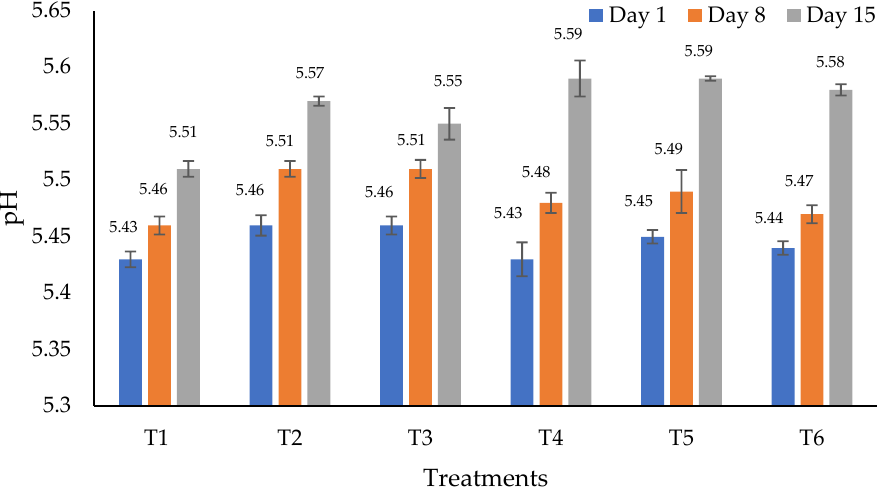
Figure 1. pH values (mean) of beef hamburgers added to essential oils of rosemary ( Rosmarinus officinalis ) and garlic ( Allium sativum ) and oleoresins of chipotle pepper ( Capsicum annum ). T1 = control, T2 = 1% garlic essential oil ( w / w ), T3 = 1% rosemary essential oil ( w / w ), T4 = 0.5% chipotle pepper oleoresin ( w / w ), T5 = 1% garlic essential oil + 0.5% chipotle pepper oleoresin ( w / w ) and T6 = 1% rosemary essential oil + 0.5% chipotle pepper oleoresin ( w / w ). There was no difference between treatments ( p > 0.05).